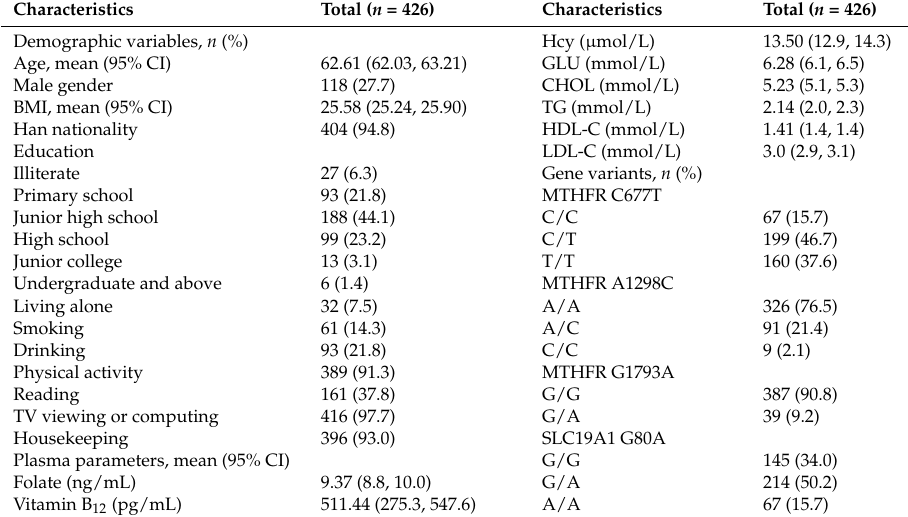
Table 1. Demographic characteristics of the